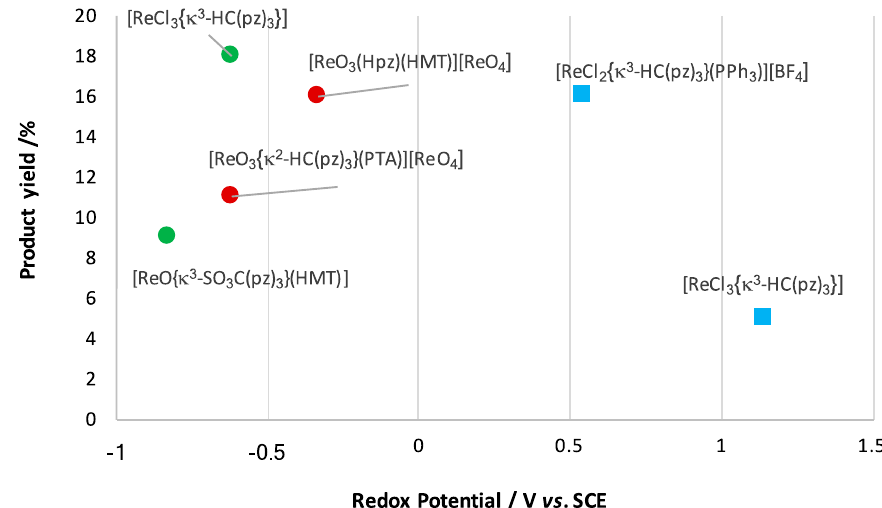
Figure 6. Yields of: ( (cid:4) ) acetic acid produced from the one-pot oxidation of ethane catalyzed by the Re(III) complexes vs. their Re(III) oxidation potentials; ( • ) 6-methylhexanolide obtained from Baeyer-Villiger (BV) oxidation of 2-methylcyclohexanone, vs. their Re(VII) oxidation potentials; and ( • ) 6-methylhexanolide from BV oxidation of 2-methylcyclohexanone, vs. their Re(III) oxidation potentials.